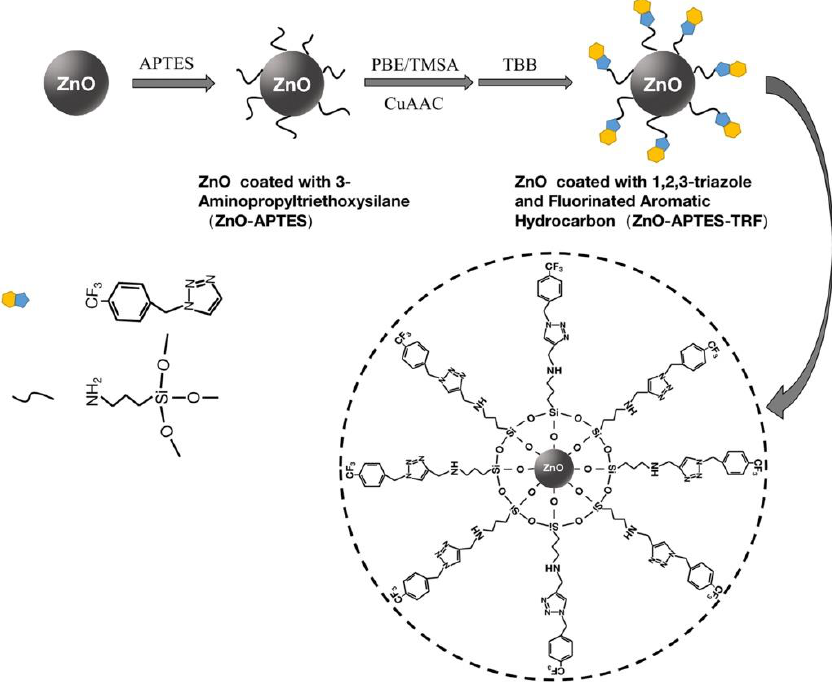
Figure 1. Modification and preparation process of ZnO − APTES −